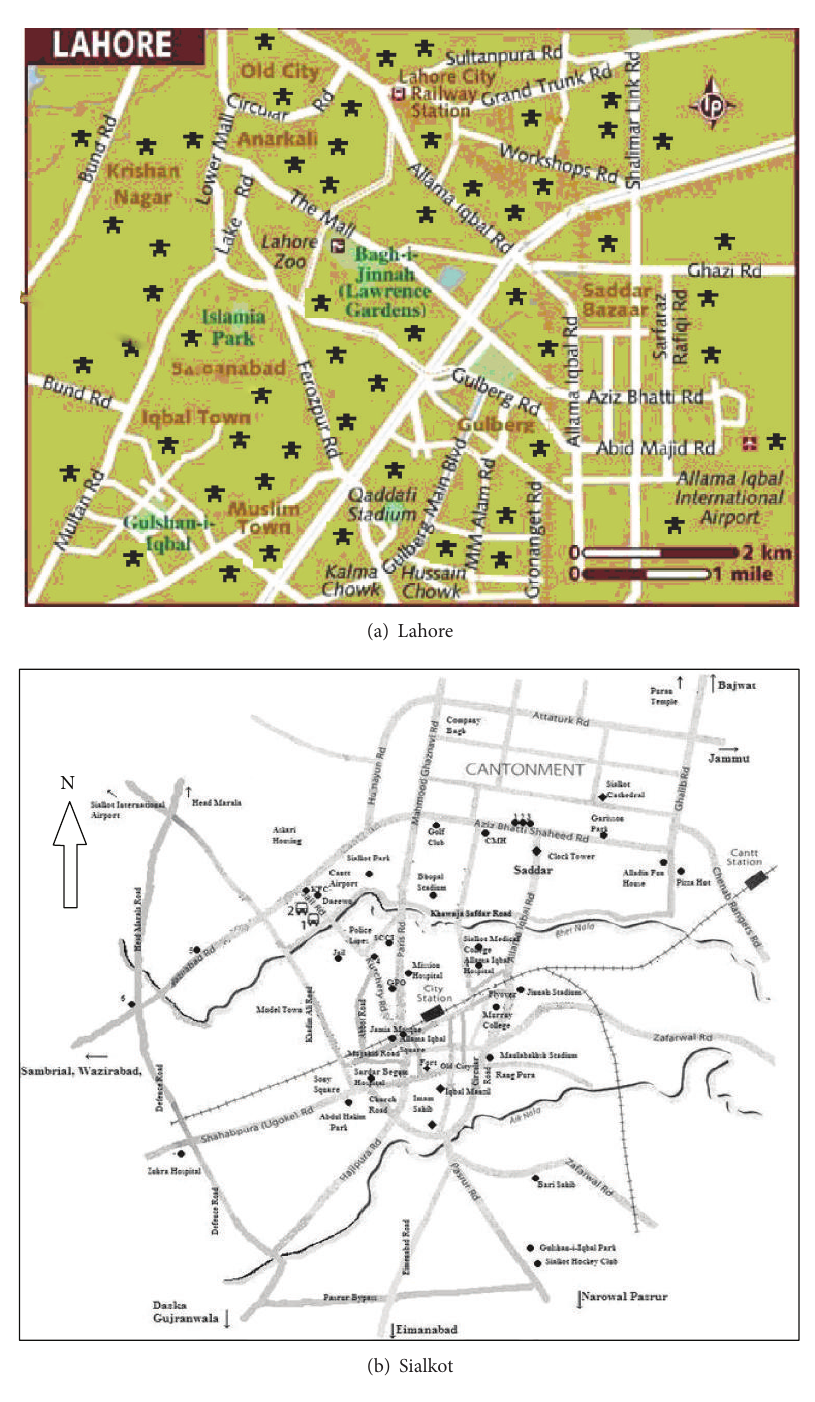
Figure 1: Sampling location ( ∗ ) of drinking water samples from Lahore and